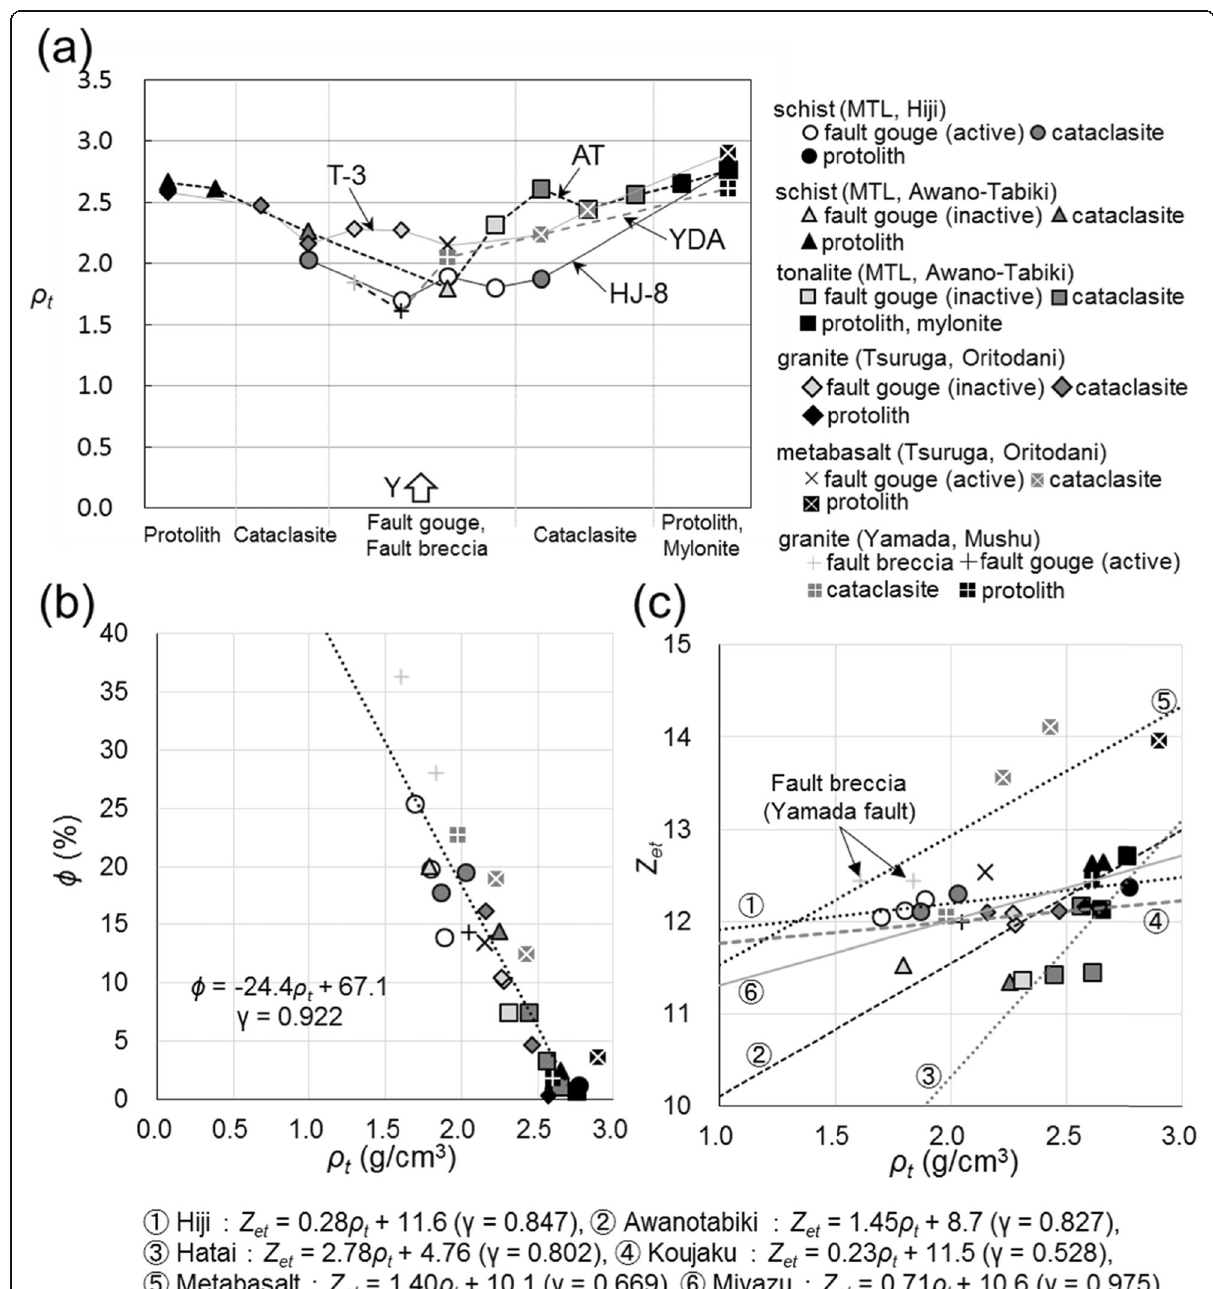
Fig. 5 Density, porosity, and effective atomic number measurement results. a Relationship between fault rock type and real density, ρ t . b Crossplot of porosity, ϕ , versus ρ t . c Crossplot of the effective atomic number, Z et , versus ρ